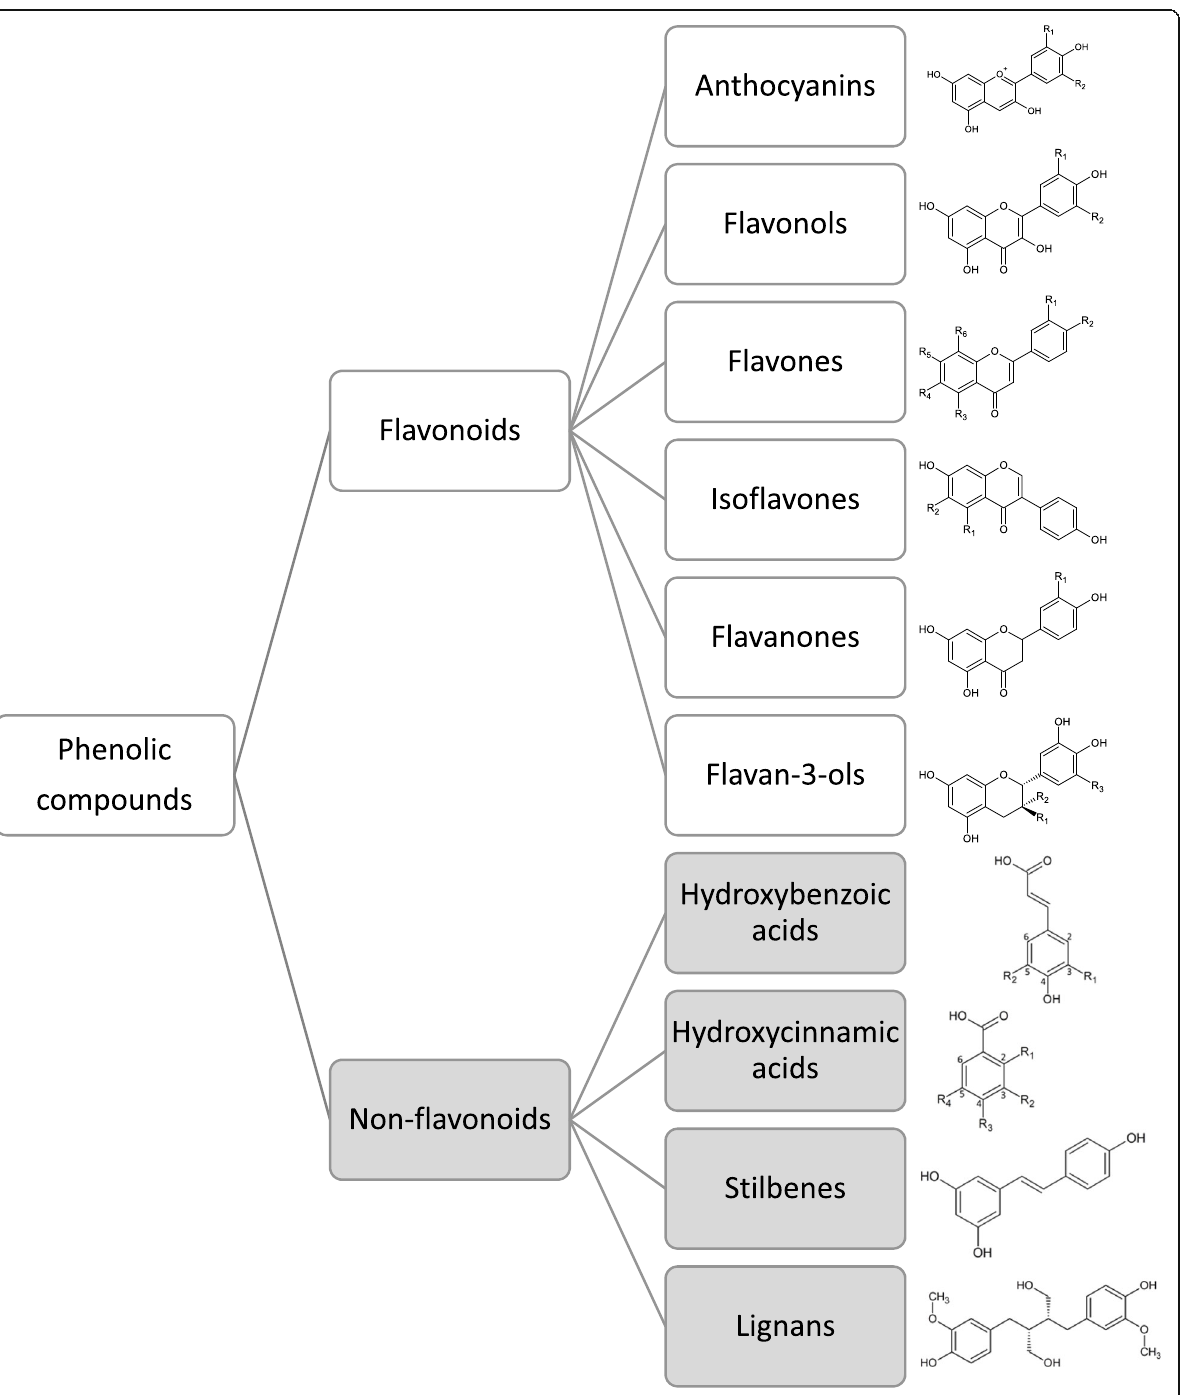
Fig. 1 Classification of phenolic compounds. R 1 through R 4 may be -H, -OH or -OCH 3 depending on the specific compound in each